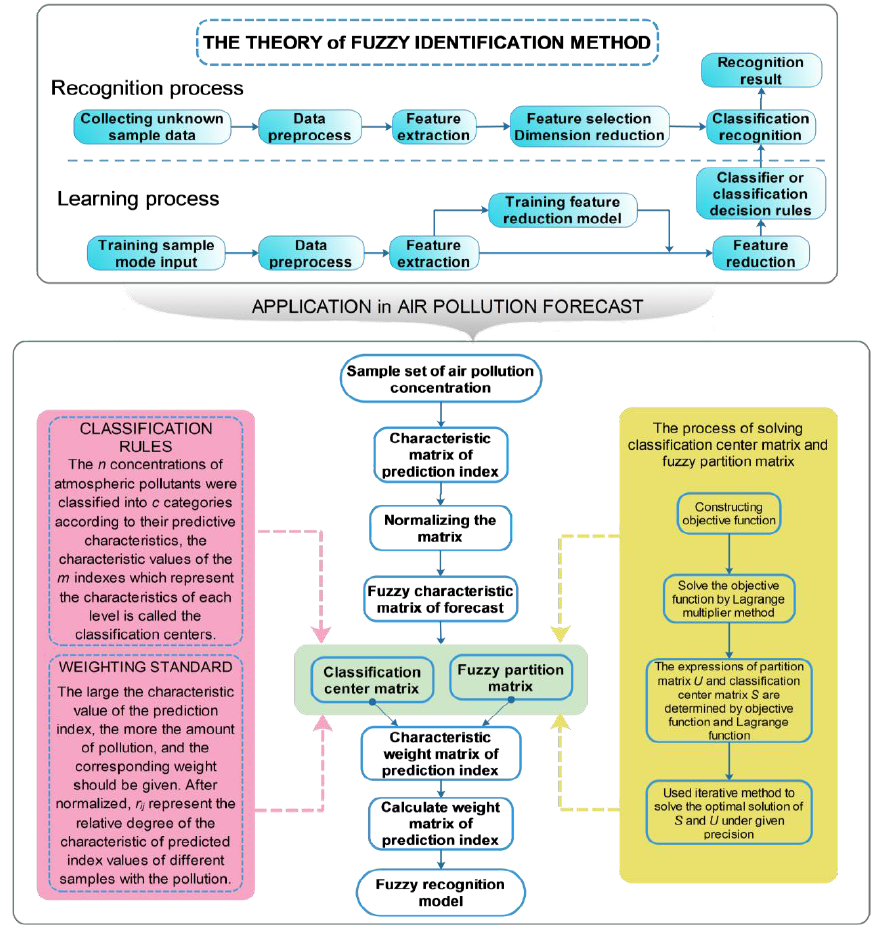
Figure 4. The flaw chart of fuzzy identification.